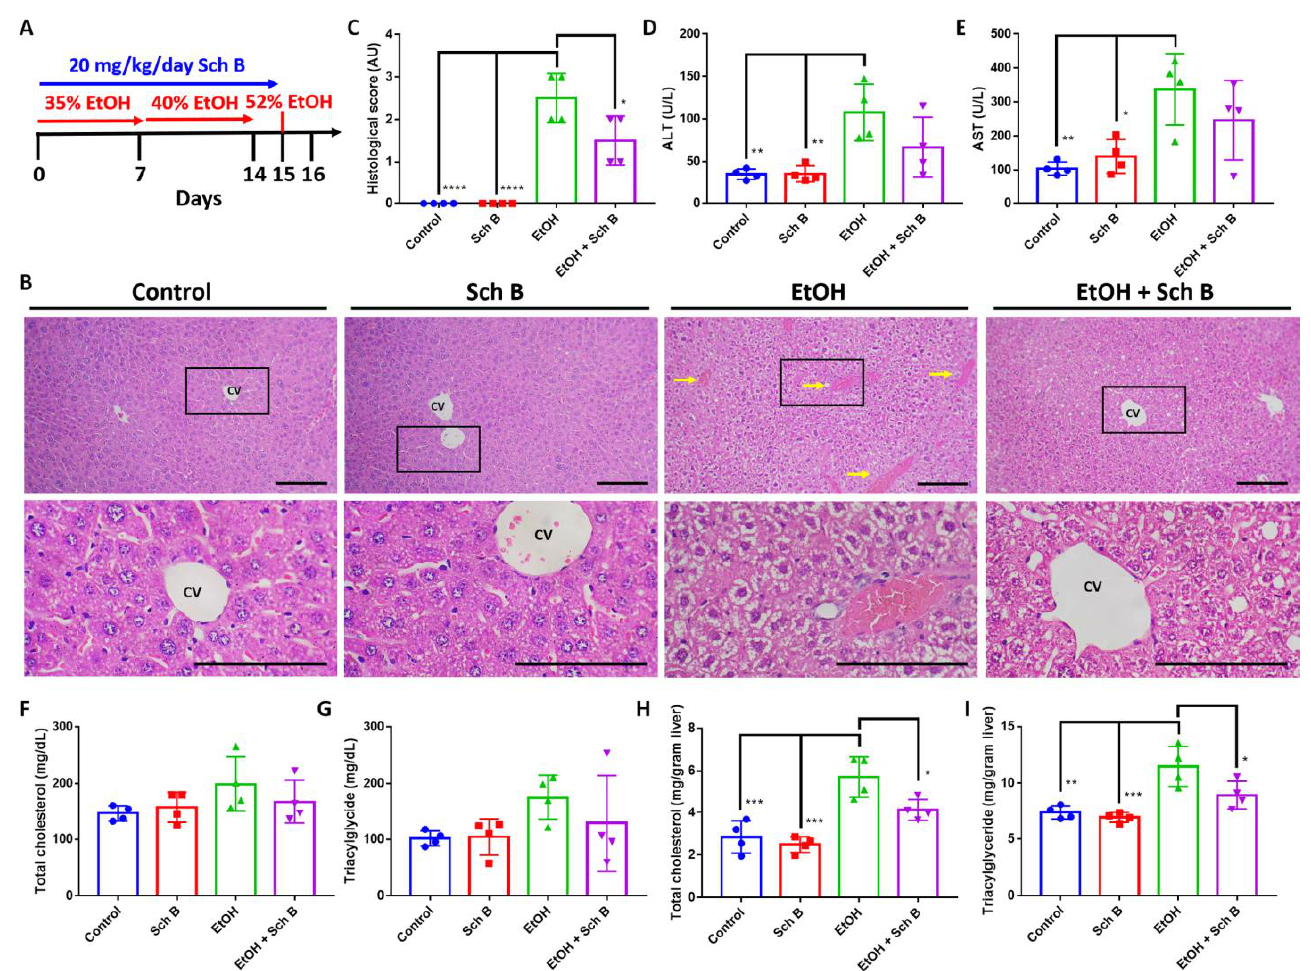
Figure 2. Schisandrin B prevents liver injuries in mice consuming ethanol. ( A ) Experimental design scheme. ( B ) Representative H&E-stained histological images showing the liver pathology of the control, Sch B-treated, ethanol-challenged, and ethanol-challenged + Sch B-treated mice. Congestion (yellow arrows) and ballooning degeneration were seen in the ethanol-treated mice, which improved after Sch B treatment. The scale bar corresponds to 200 μm. CV, central vein. ( C ) Histological scores based on the histological slides from ( B ). Serum levels of ( D ) ALT, ( E ) AST, ( F ) total cholesterol, and ( G ) triacylglycerides. Hepatic levels of ( H ) total cholesterol and ( I ) triacylglycerides. n = 4 mice. Results are expressed as mean ± SD. * p < 0.05, ** p < 0.01, *** p < 0.001, and **** p < 0.0001.